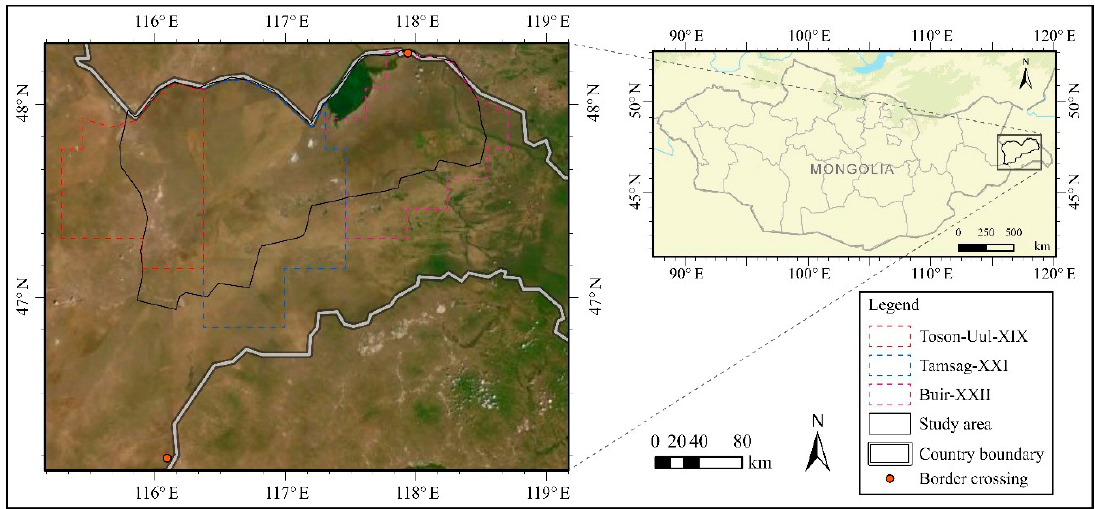
Figure 1. Study area map. The study area is a part of the Eastern Mongolian Steppe, which is one of the largest flat-steppes of Mongolia. The study area is registered in the World Heritage List of the